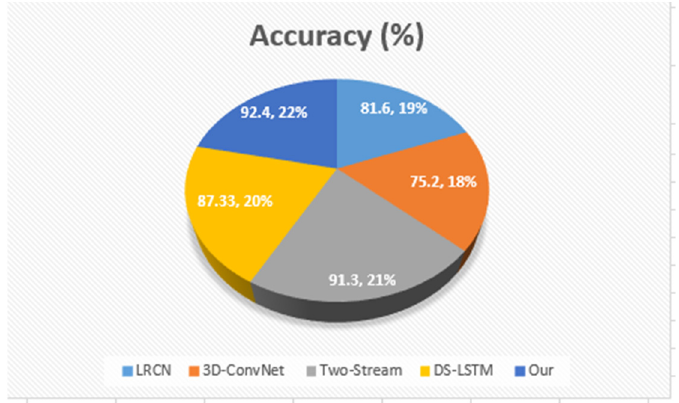
Figure 8. Accuracy comparison with other methods using the Kinetics-Motion dataset.